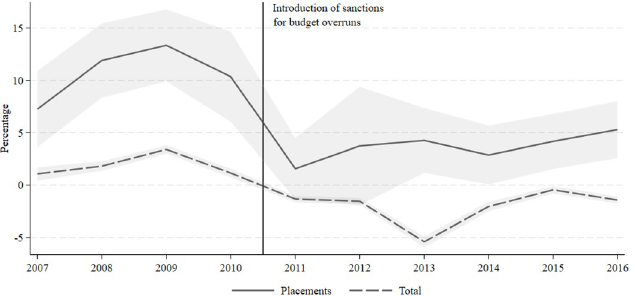
Fig 1. Budget overruns on out-of-home care. The graphs shows the average of annual actual expenses—expenses in the budget relative to the budget. The solid line is for expenses on out-of-home placement whereas the dashed line is for all municipality expenses. The vertical line indicates the introduction of sanctions against budget overrun. The shaded area indicates the 95 percent confidence interval. Source: Own calculations based on data from Statistics Denmark, Statistikbanken, Table BUDK53 and